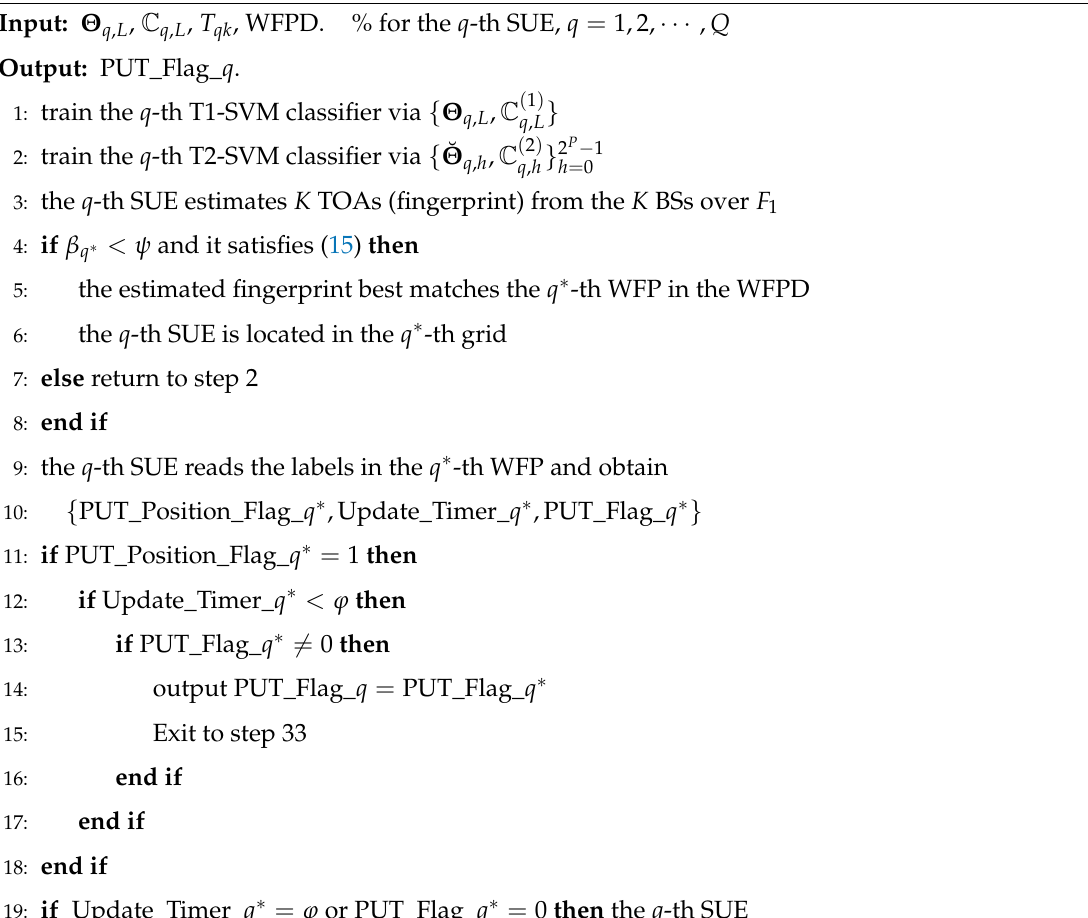
Algorithm 1 Geo-location information aided spectrum